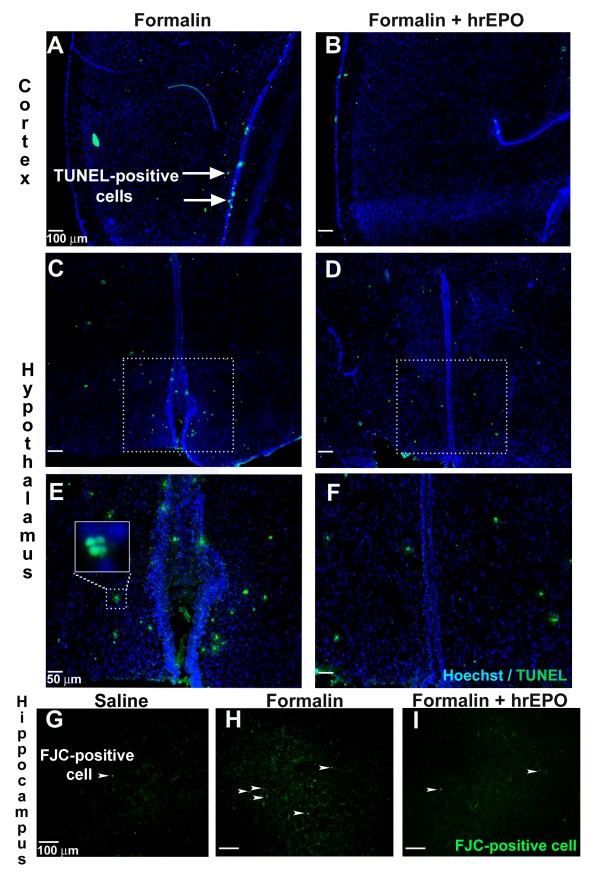
Effect of rhEPO on inflammatory pain-induced cell death. rhEPO reduced cell death in the cortex, hypothalamus and hippocampus after 3 formalin injection sessions (72 hrs). A - F: Immunofluorescent images of TUNEL-positive cells (arrow) in the cortex (A and B) and the hypothalamus (C and D). E and F are magnified selected areas in C and D, respectively. The inset in E is a further enlarged (40×) image of the selected area (Blue: Hoechst, green: TUNEL). G - I: Immunofluorescent images of fluoro-Jade C positive neurons (arrowheads) in the hippocampus after 3 repetitive saline (G), formalin (H) or formalin plus rhEPO injection (I) sessions (green: FJC-positive cell). Bar = 100 μm for A to D, 50 μm for E and F, and 100 μm for G to I.